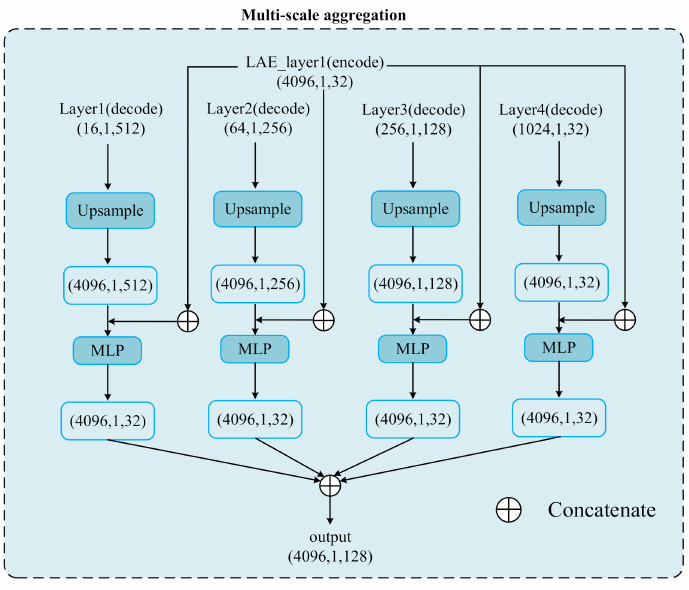
Figure 5. Multi-scale aggregation module. The input is the output features of the first LAE layer of the encoder. Layer1 (decoder) indicates the first layer of the decoder with the lowest spatial resolution.